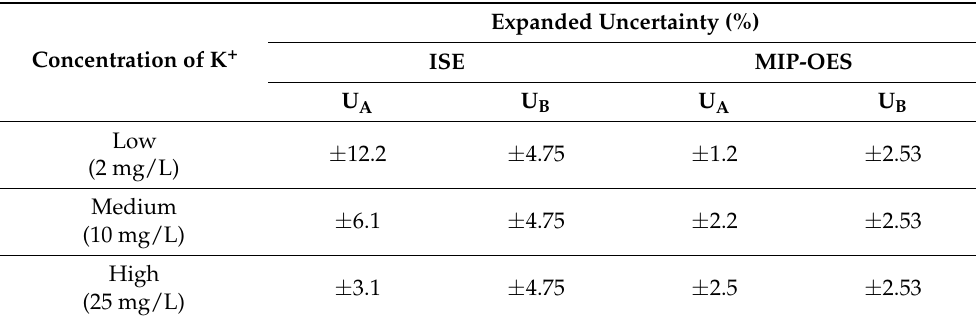
Table 10. Summary of the uncertainty budget results of types A (experimental) and B (nonexperi- mental) for determining potassium ion concentration using ISE and MIP-OES methods. Expanded Uncertainty (%) Concentration of K +